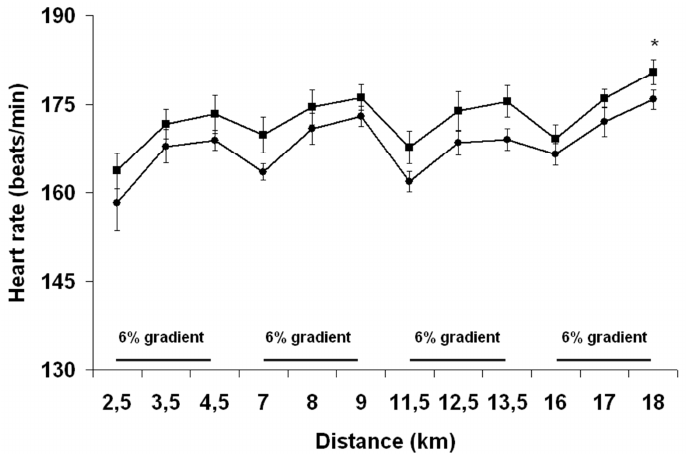
Figure 6. Change in heart rate throughout the run with pre-exercise euhydration ( ■ ) and hyperhydration ( ● ). * Significant trial effect. Results are mean ±